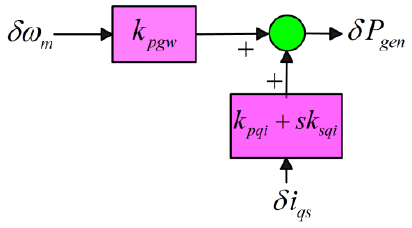
Figure 5. Small-signal block diagram of generator output power.